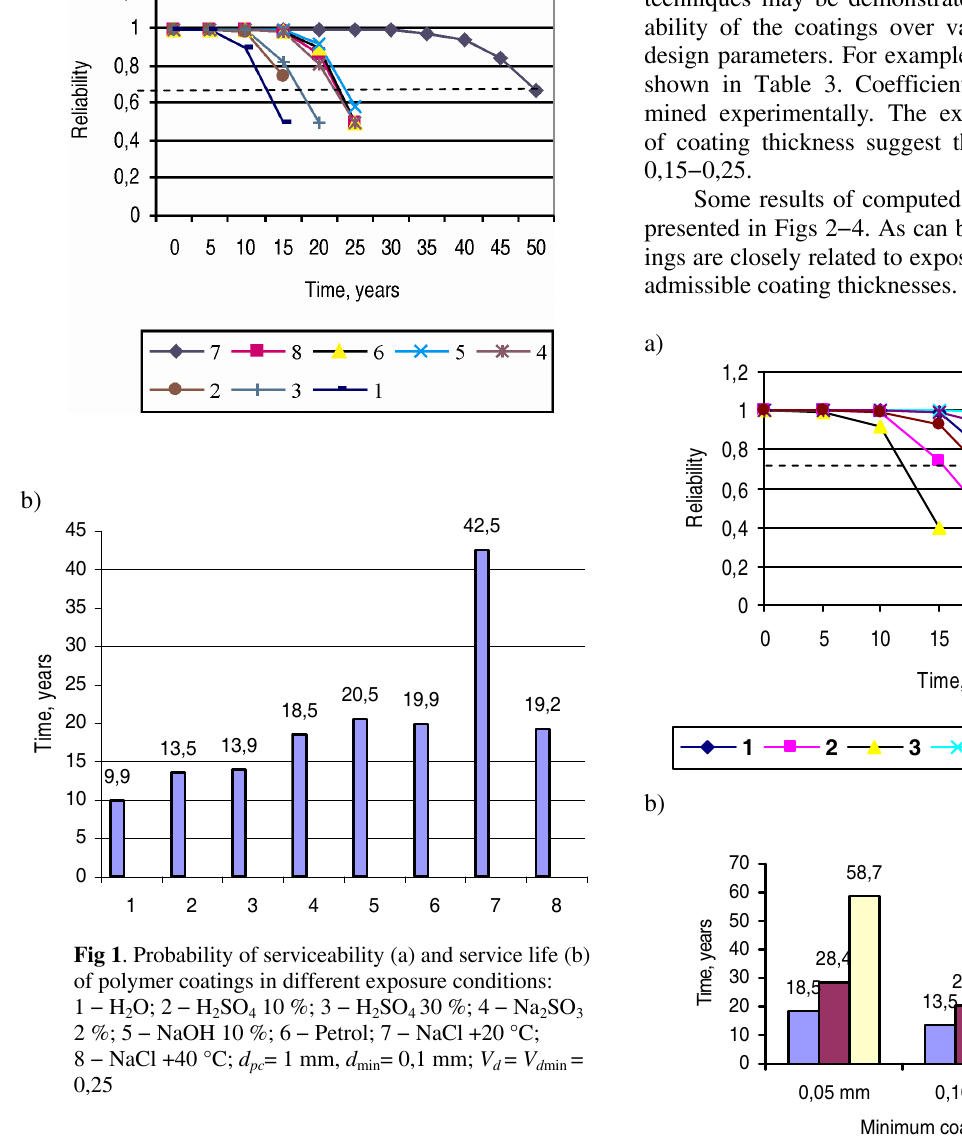
Table 3 . Typical coating parameters s d Mean Cov Variables Distribution Fig 2 . Effect of d min on the reliability (a) and service life mm m d (b) of polymer coatings of d 0 = 1 mm, V d = V d. min = 0,25: Normal Initial coating 1 (H 2 SO 4 , 10 %) and 4 (NaOH 10 %) – d min = 0,05 mm; thickness, d pc 2